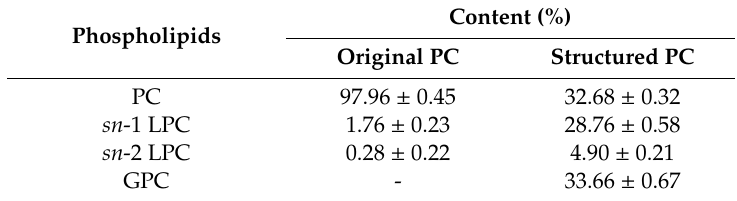
Table 1. The composition of phospholipids of the substrate PC and structured PC after 72 h of reaction. Content Phospholipids